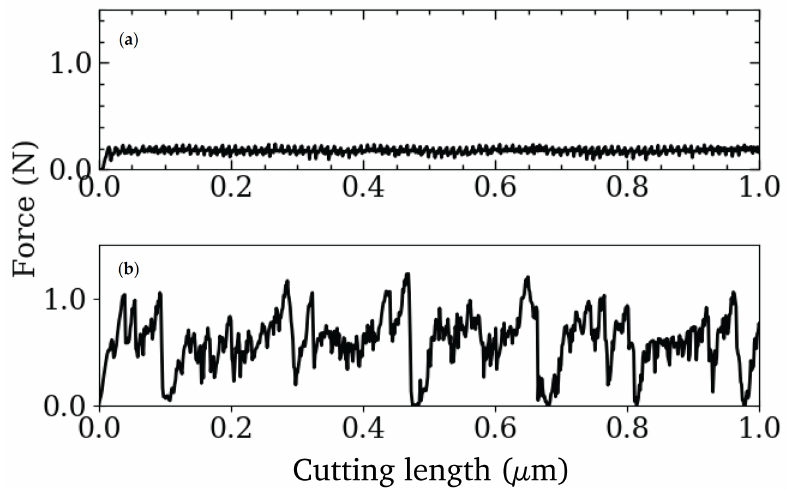
Figure 10. Cutting force vs. cutting length for the ( a ) 20 nm, and ( b ) 30 nm depth at a rake angle of − 15 ◦ . The force at depth lower than the BDT is characterized by an oscillatory small-sawtooth-like behavior around 0.2 N while cutting force at a depth larger than transition depth is characterized by large oscillatory